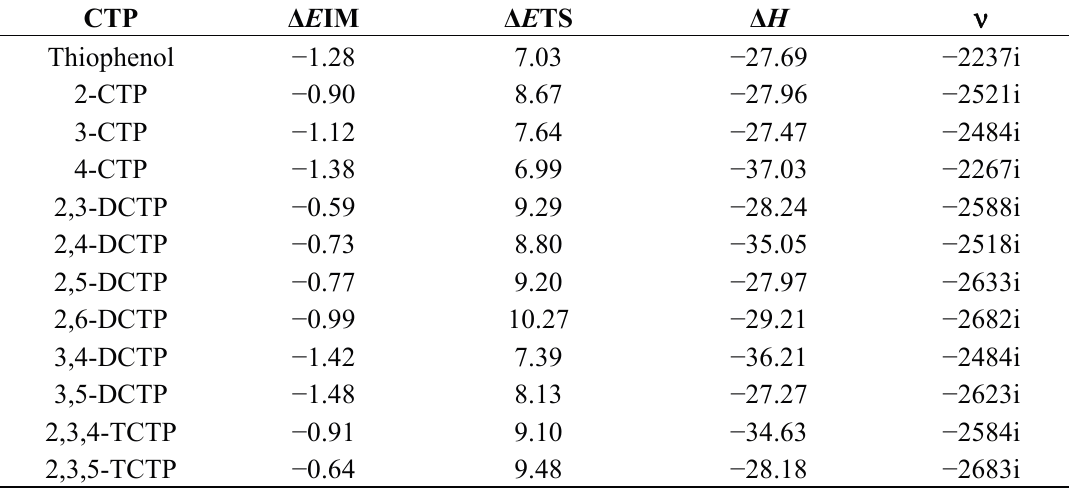
Figure 3. MPWB1K/6-31+G(d,p) optimized geometries for the prereactive intermediates of the thiophenoxyl-hydrogen abstraction from CTPs by OH. Distances are in angstroms. Gray sphere, C; White sphere, H; Yellow sphere, S; Red sphere, O; Green sphere, Cl. (For interpretation of the references to color in this figure legend, the reader is referred to the web version of this article.). Table 2. The relative energies of the intermediates ∆ E IM (in kcal/mol), potential barriers ∆ E TS (in kcal/mol), reaction heats ∆ H (in kcal/mol, 0 K), imaginary frequencies (in cm − 1 ) of the transition states for the triophenoxyl-hydrogen abstraction from CTPs by